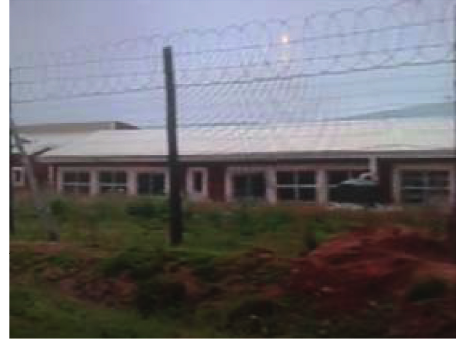
Figure 2: School built by shell SA: site two.